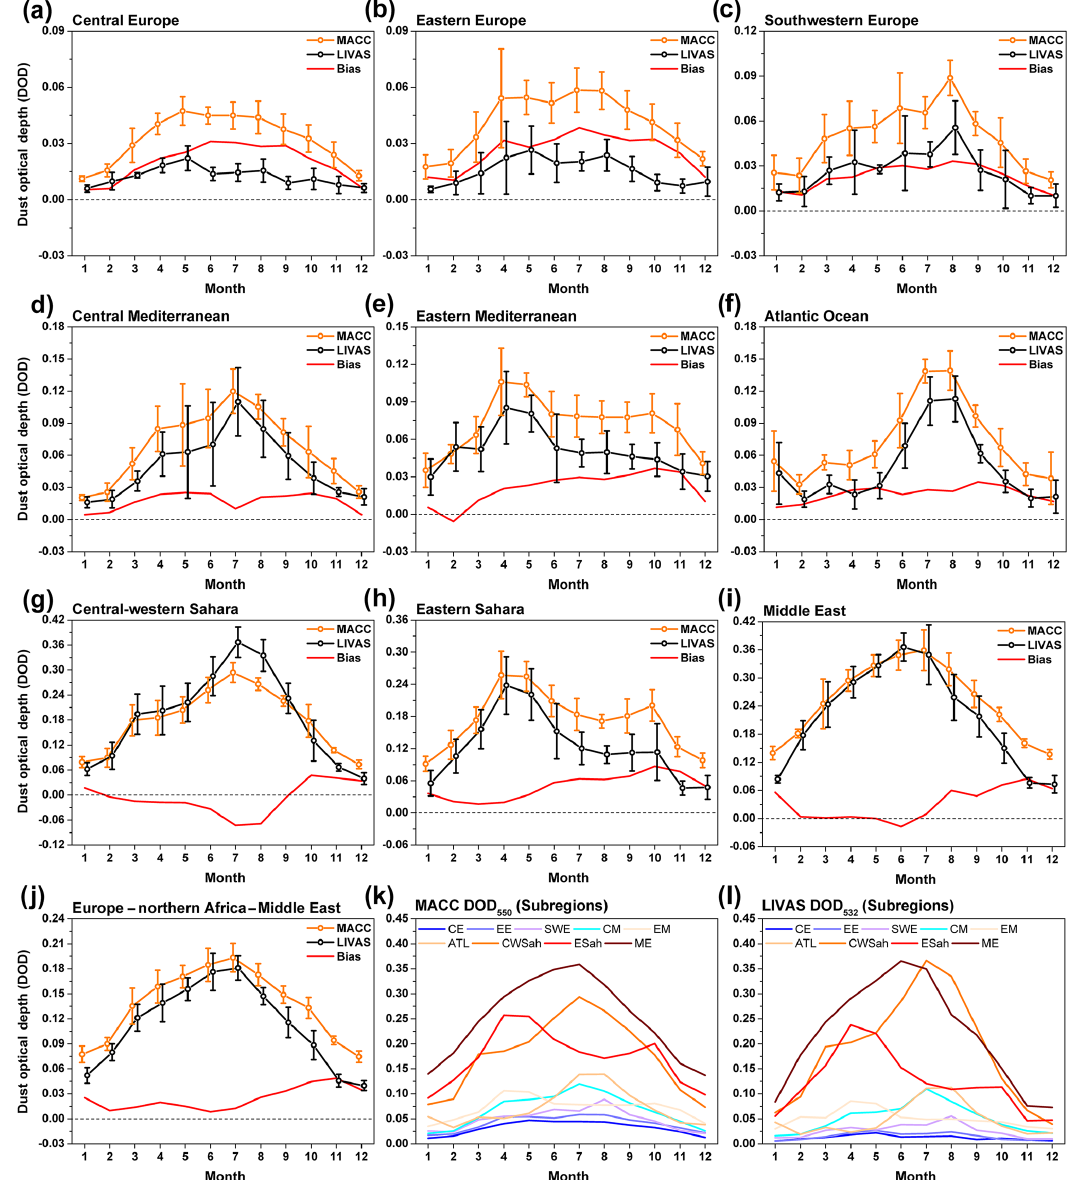
Figure 4. Monthly variability of the MACC DOD 550 (orange color), the LIVAS DOD 532 (black color) and their mean bias (red color) over the nine subregions of interest (a–i) and over the whole Europe–northern Africa–Middle East domain (j) . Different scales are used for each subregion so that the differences between the two datasets per subregion are depicted more efficiently. The monthly variability of DOD for all the subregions of interest together for MACC (k) and LIVAS (l) is also presented here to get an insight into the differences in DOD levels over different